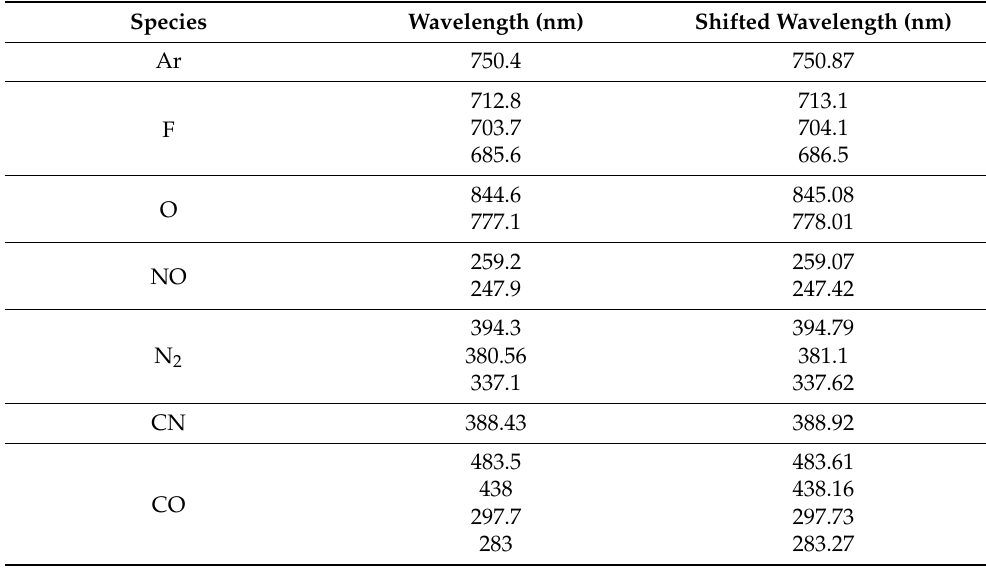
Table 2. Information on wavelengths used in the Results and Discussion section with their original